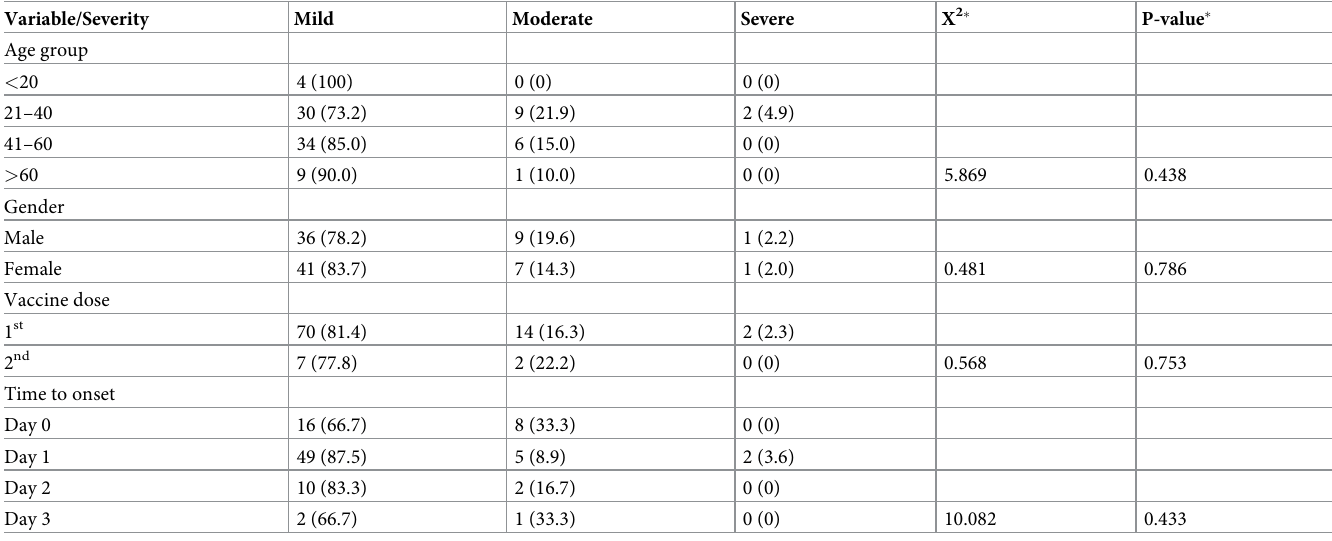
Table 5. Adverse event severity based on age, gender, dose and time to onset.